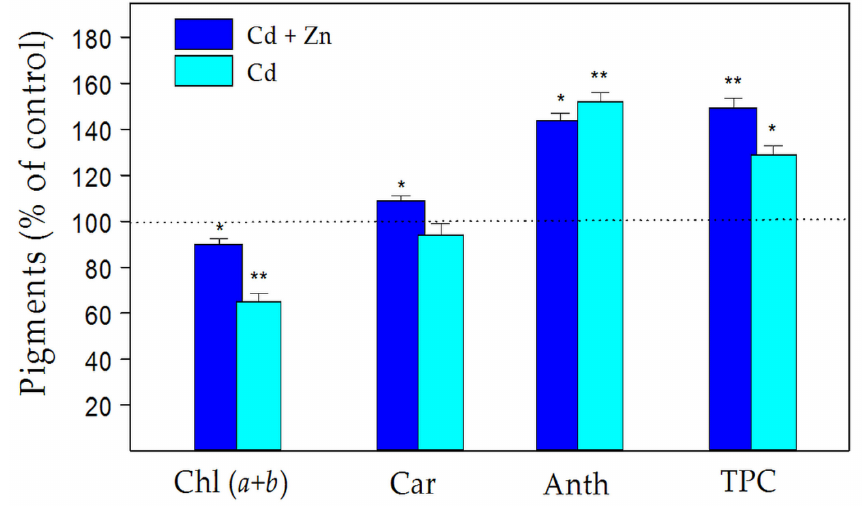
Figure 5. Effects of excess (900 µ M) Zn on Cd-induced changes in the content of leaf pig- ments: the total chlorophyll content (Chl a+b, 100% = 2.04 ± 0.07 mg g —1 FW), carotenoids (Car, 100% = 0.48 ± 0.03 mg g —1 FW), anthocyanins (Anth, 100% = 0.31 ± 0.02 mg g —1 FW), and total phenolic content (TPC, 100% = 6.64 ± 0.17 mg g —1 FW) of Salvia sclarea after 8 days of exposure. Mean values ( ± SD, n = 3) are expressed as % from the respective controls. Asterisks indicate signifi- cant differences between control and treatments using one-way ANOVA analysis using Fisher’s LSD test (* p < 0.05 and ** p <